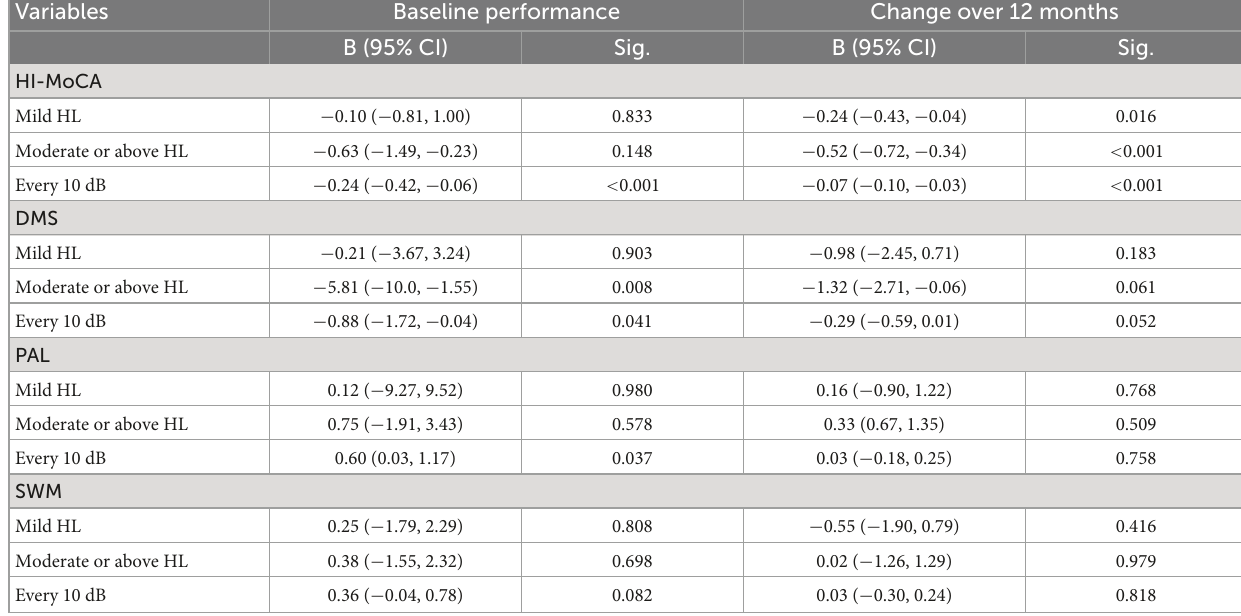
TABLE 4 Multivariable adjusted regression change over 12 months of cognitive performance by baseline hearing loss.